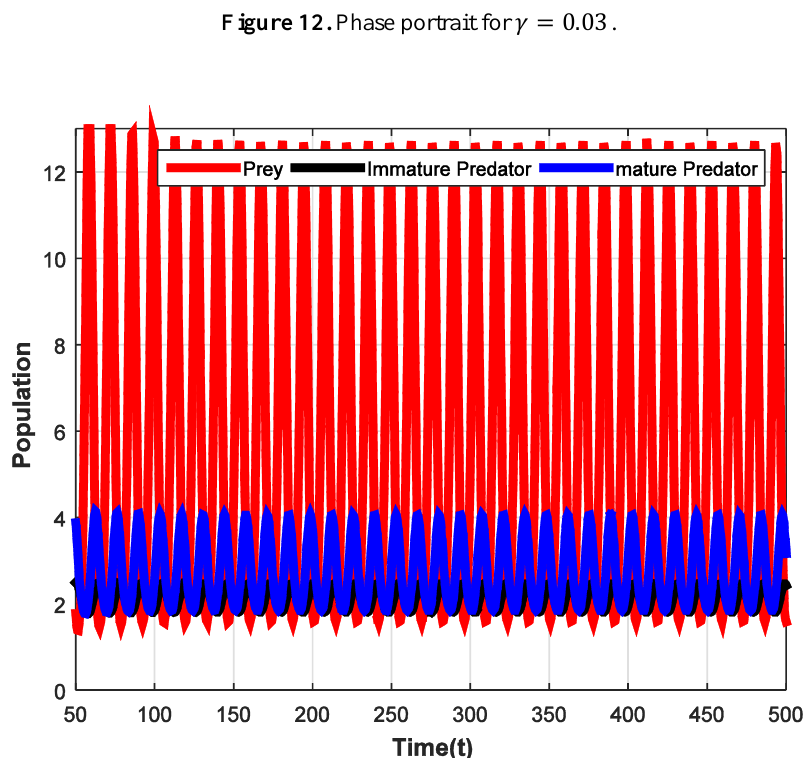
Figure 13. Population graph for 𝛾 =